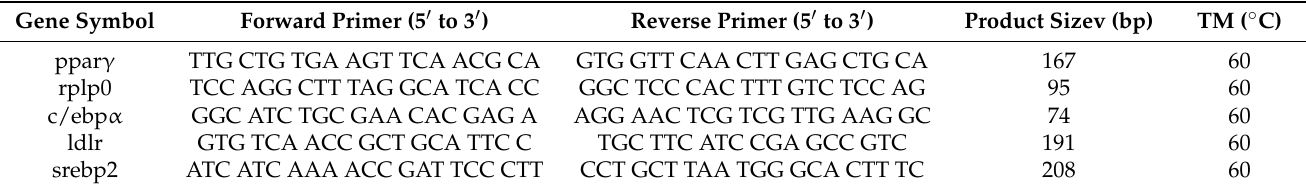
Table 3. Primer sequences used for real-time